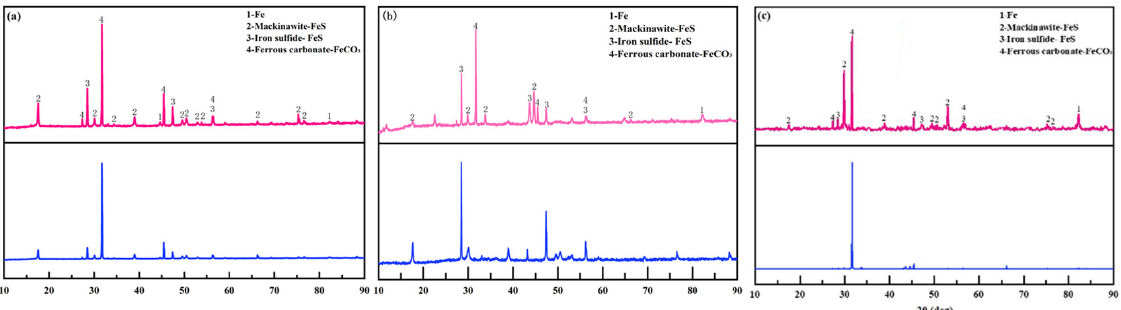
Figure 15. Phase composition of corrosion scales of T95 steel in the liquid and gas phase (( a – c ) is 90 °C,120 °C,150 °C).